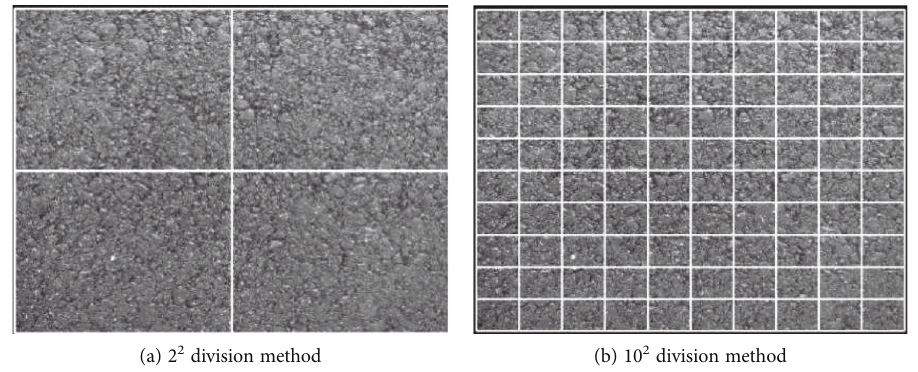
Figure 6: Area division method for pavement